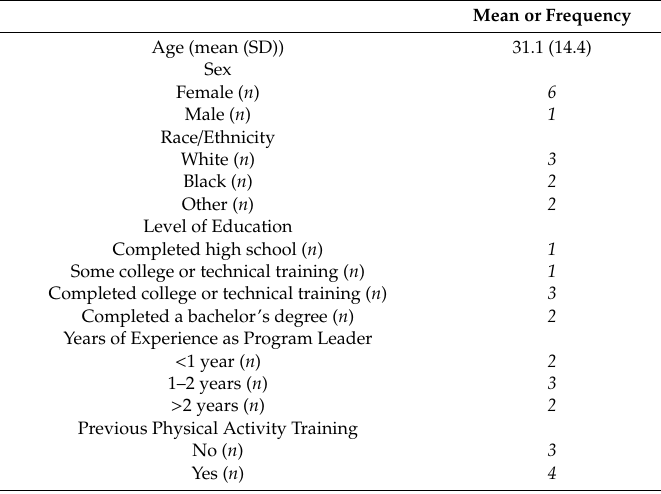
Table 1. Descriptive characteristics of the program leaders at